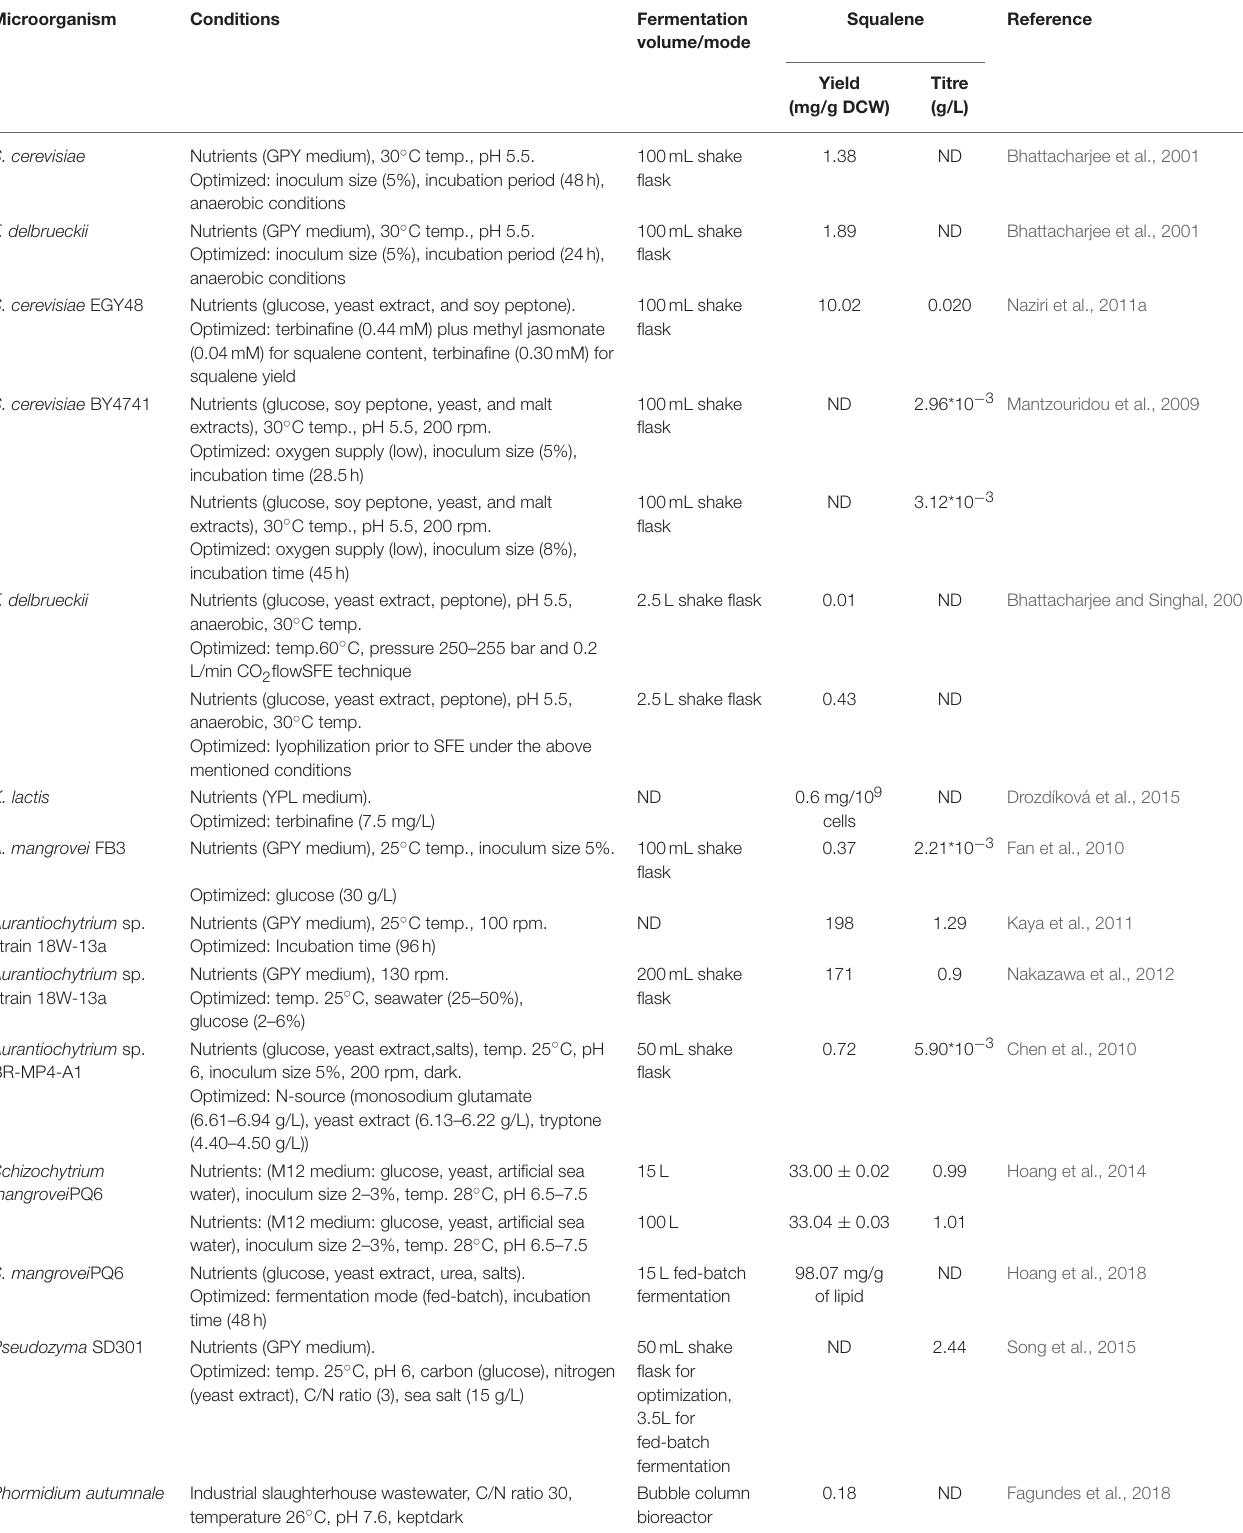
TABLE 3 | Fermentation optimization for squalene production. Microorganism